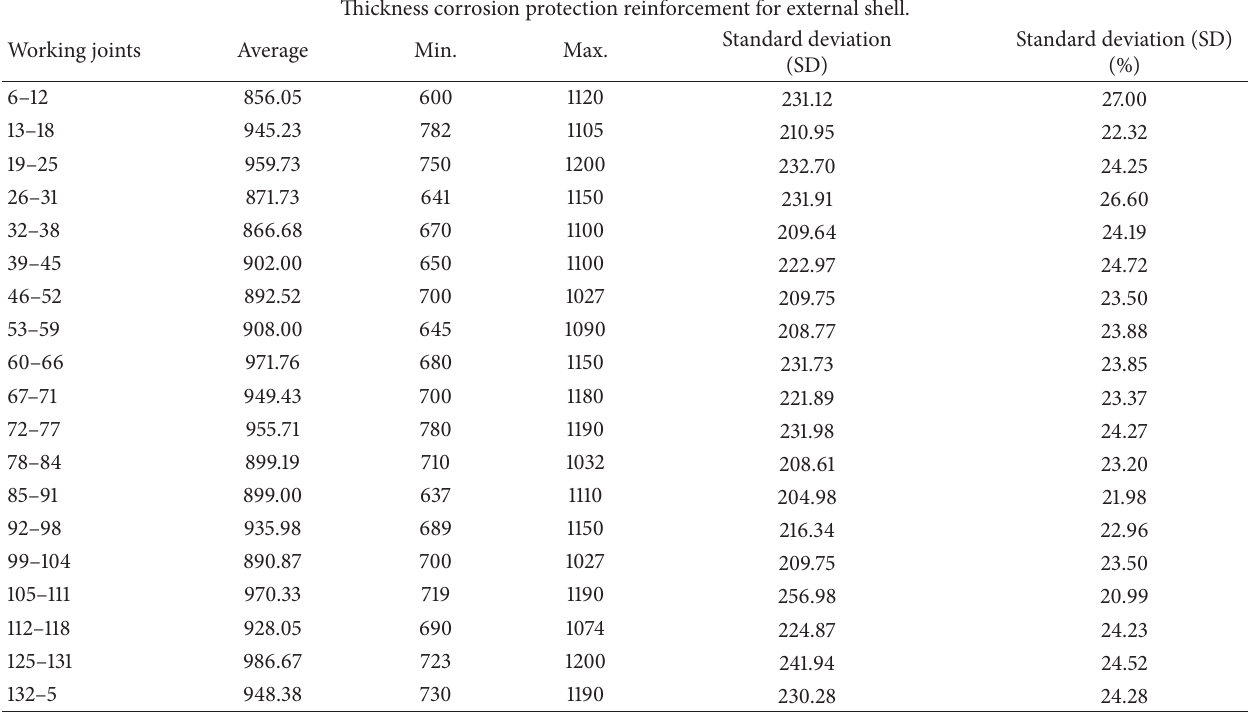
Table 3: Thickness corrosion protection in 𝜇 m of reinforcement for internal shell.